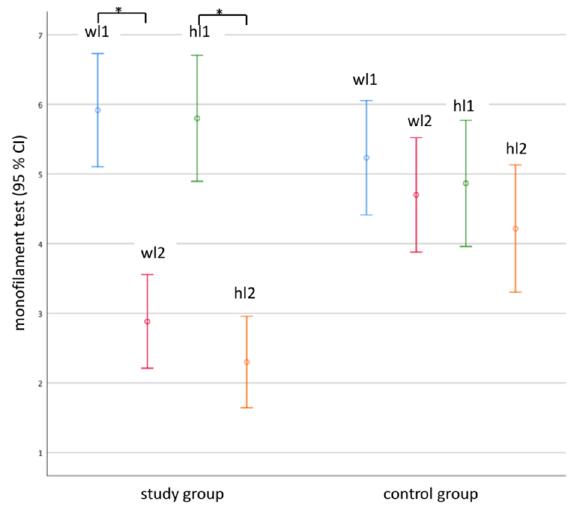
Figure 1. Monofilament test before and after the treatment. * p < 0.001.